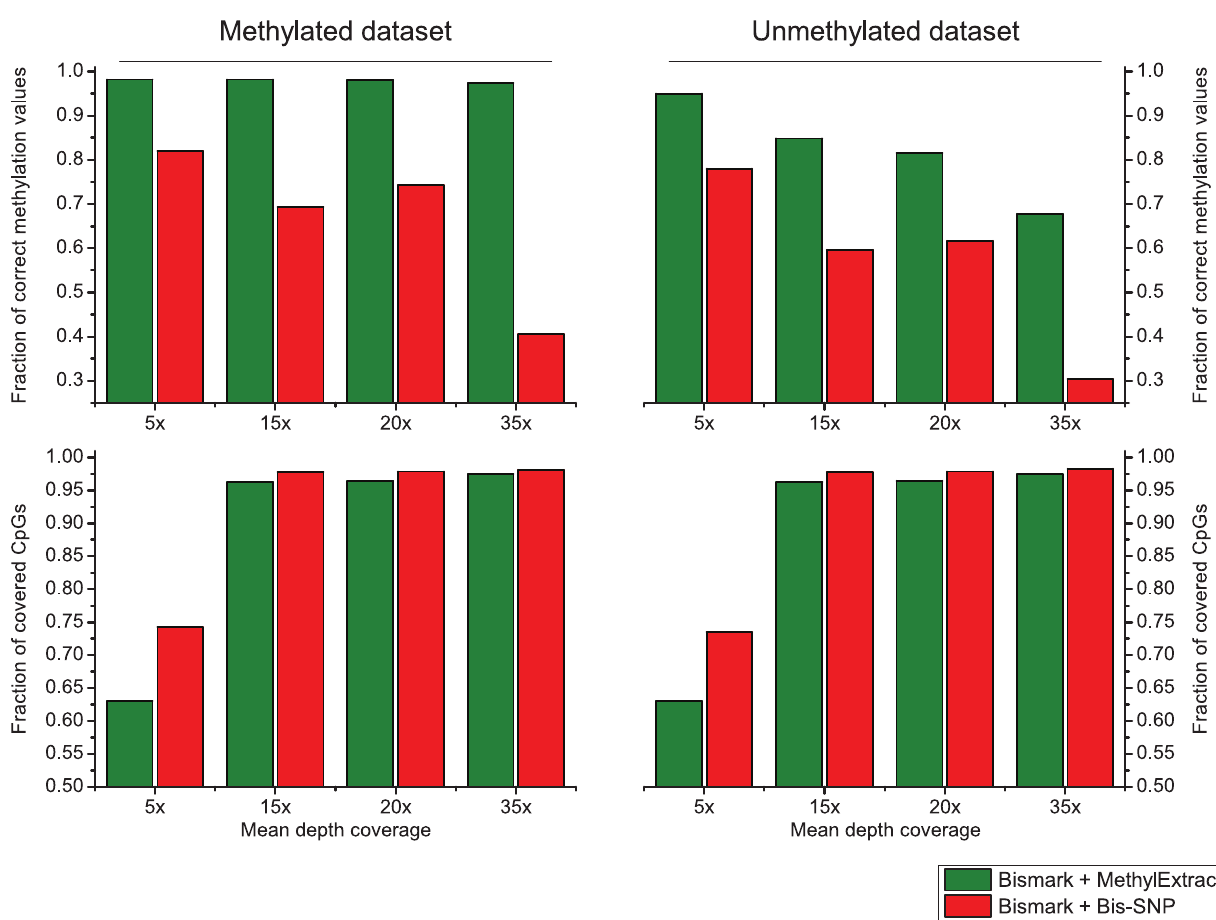
Figure 7. Comparison of CpG methylation values between MethylExtract and Bis-SNP . Both methods are compared in terms of fraction of correctly profiled CpG methylation values (top) and the fraction of recovered CpG positions